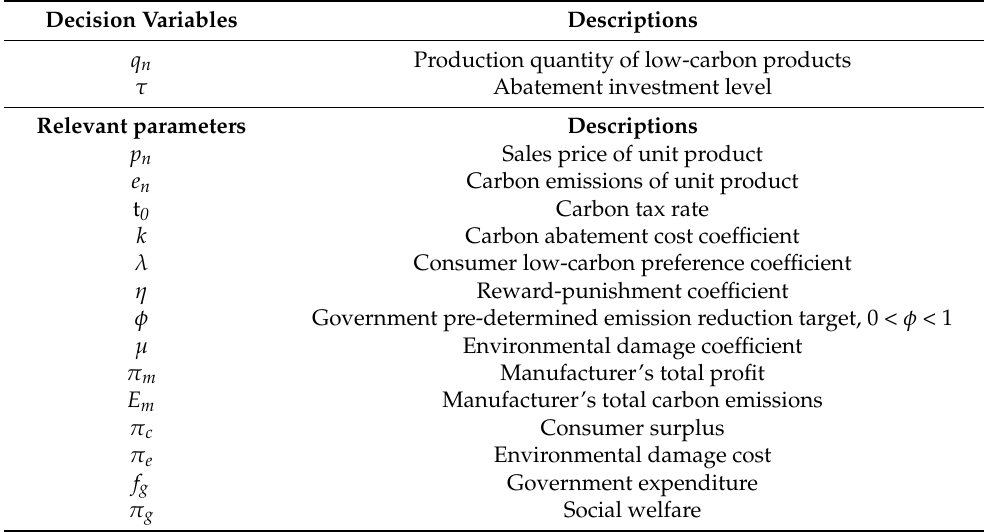
Table 2. Relevant parameters and decision